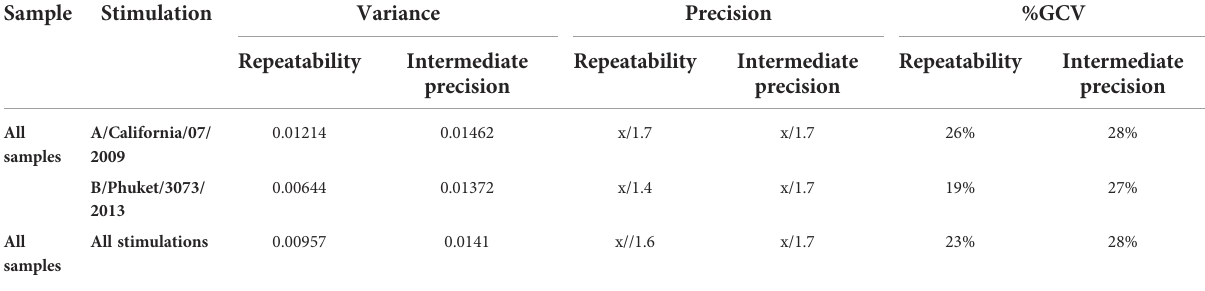
TABLE 4 Precision results for eight samples for each stimulation (A/California/07/2009 and B/Phuket/3073/2013). Sample